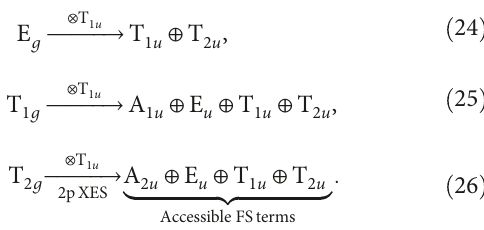
Figure 19: Multielectronic term scheme for Ni 2+ 3d 8 comparing the 1s2p RIXS and direct 2p XAS pathways. Populating the T intermediate state would require a two-electron transition in 3d 8